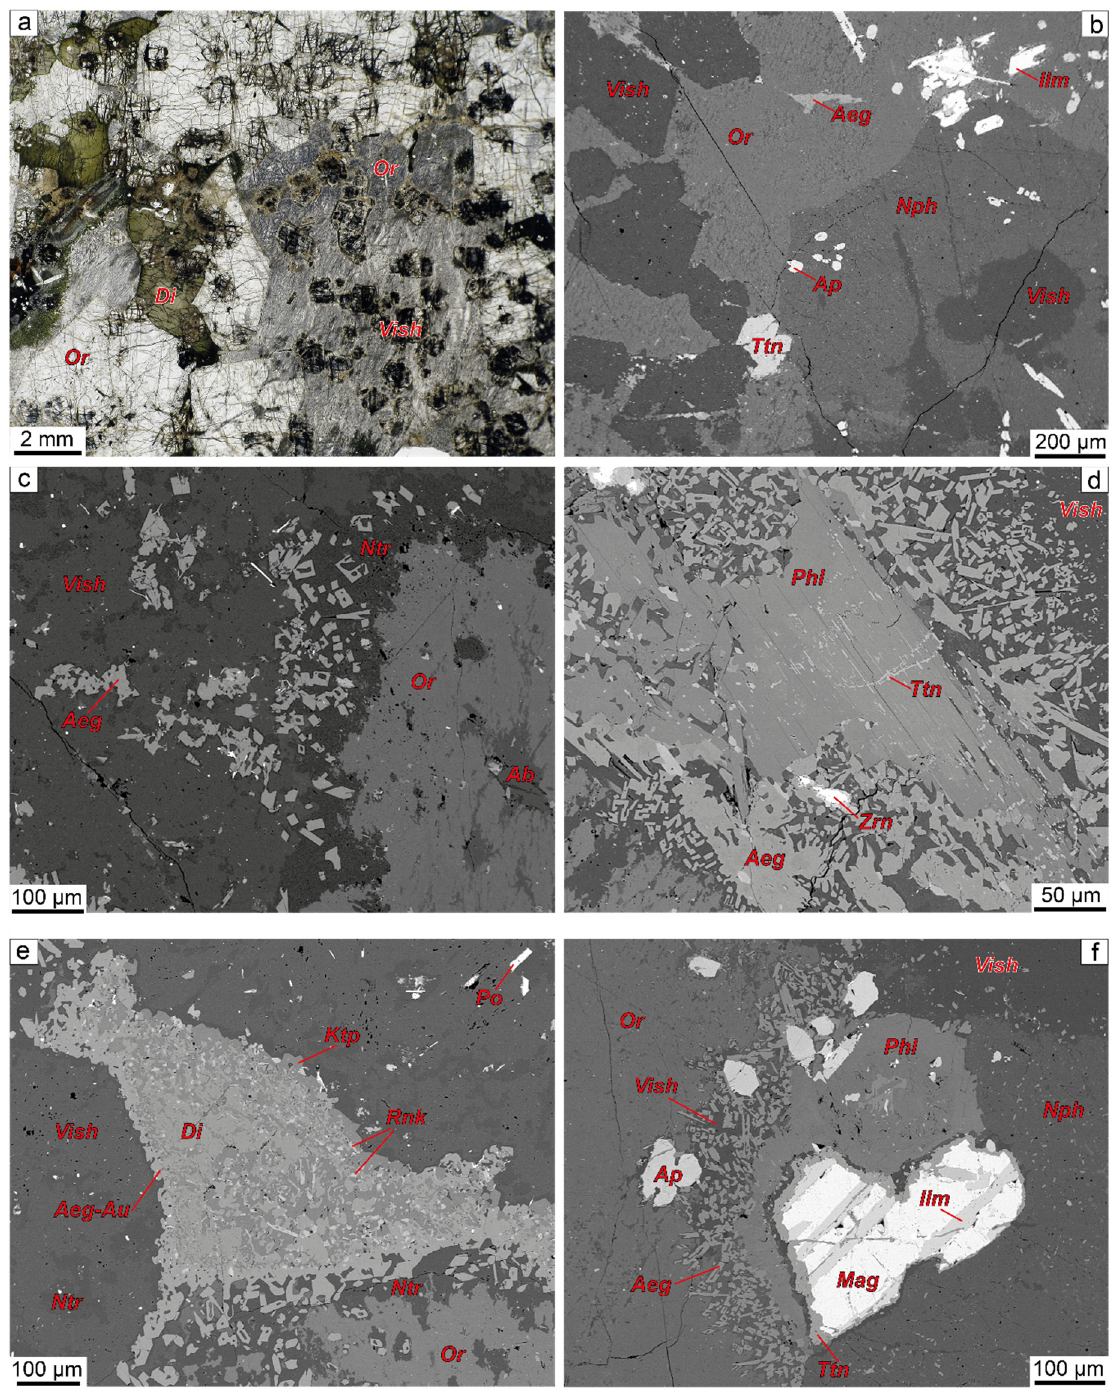
Figure 6. Photograph in transmitted light ( a ) and BSE images ( b – f ) showing the textural relations and mineral paragenesis in poikilitic foid syenite: ( a ) large poikilitic orthoclase crystals with inclusions of vishnevite is the characteristic texture of poikilitic foid syenite (Sample LV-381); ( b ) fragment of a large grain of orthoclase with inclusions of vishnevite and nepheline, nepheline is replaced by vishnevite (Sample LV-378-2), ( c ) replacement of orthoclase with natrolite and vishnevite (Sample LV-377-7); ( d ) platy crystal of phlogopite with inclusions of titanite (Sample LV-378-2); ( e ) relicts of diopside resorbed by ferri-katophorite and aegirine (Sample LV-377-8); ( f ) aegirine rim around phlogopite plates and titanite rim surrounding magnetite grain with ilmenite lamellae (Sample LV-378-2).